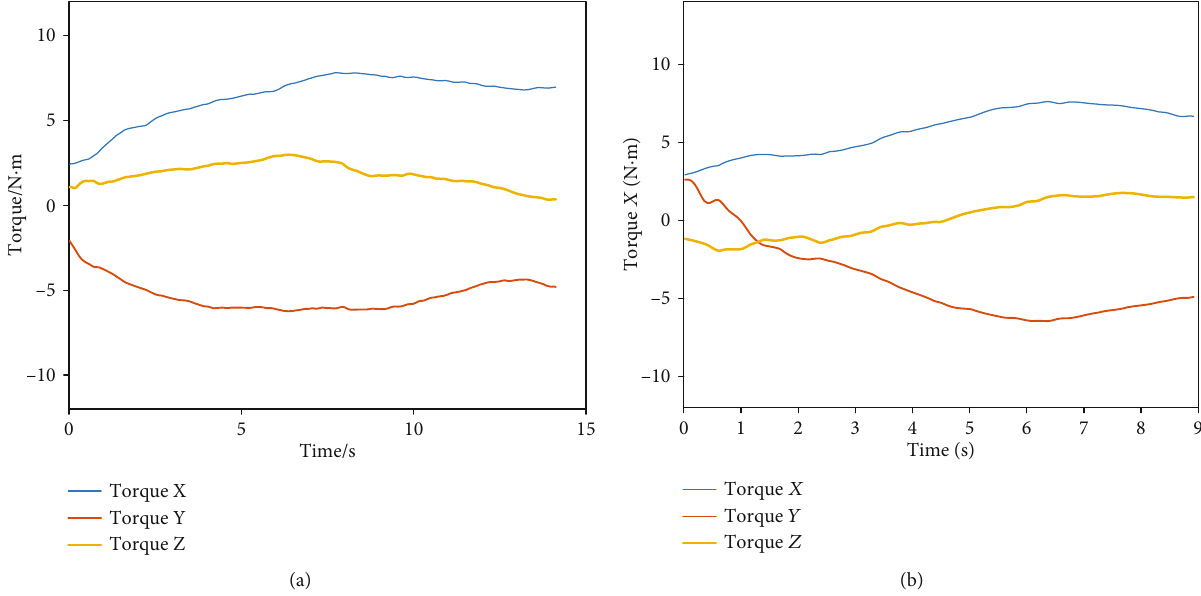
Figure 8: Shoulder joint passive torque results. (a) Passive torque components of abduction in 0 ° plane of elevation. (b) Passive torque components of abduction in about 30 ° plane of